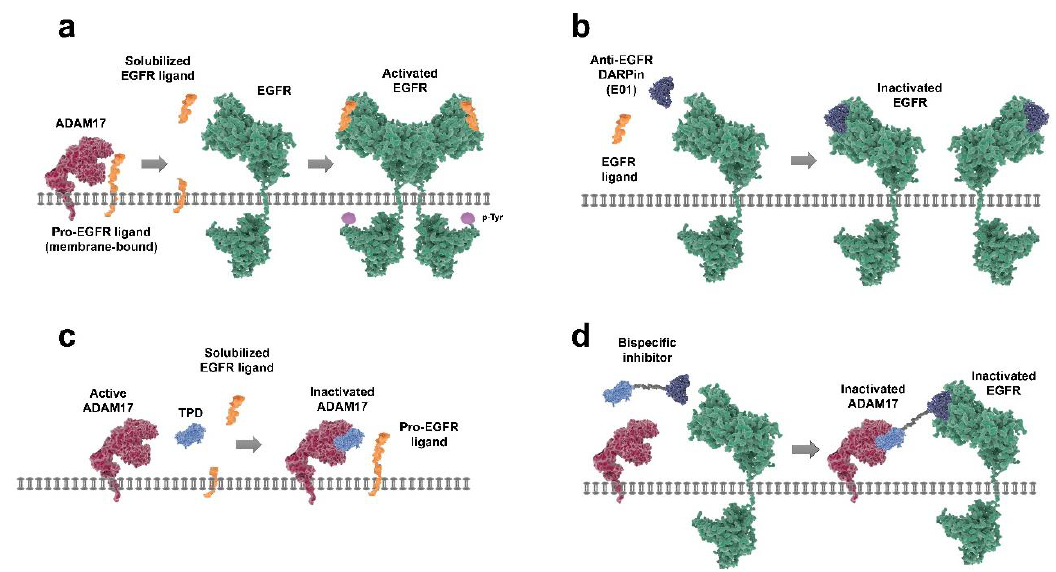
Figure 1. Therapeutic strategies for targeting the epidermal growth factor receptor (EGFR)/A disintegrin and metalloproteinase (ADAM17) axis. ( a ) pro-EGFR ligands are membrane-bound and require proteolytic cleavage by ADAM17 to generate ‘mature’ solubilized ligands that can bind to the EGF receptor. Ligand-bound EGFR can then (homo)dimerize, auto-phosphorylate, and initiate downstream signaling. ( b ) anti-EGFR designed ankyrin repeat protein (DARPin) E01 binds to EGFR in an antagonistic manner, preventing ligand binding and subsequent receptor activation. ( c ) ligand shedding can be prevented by inhibiting ADAM17 activity; for instance, by using recombinant inhibitory prodomain of ADAM17 (TPD) to block the catalytic site of active ADAM17 and preventing release of EGFR ligands. ( d ) the bispecific inhibitor (E01-GS-TPD) combines the activities of DARPin